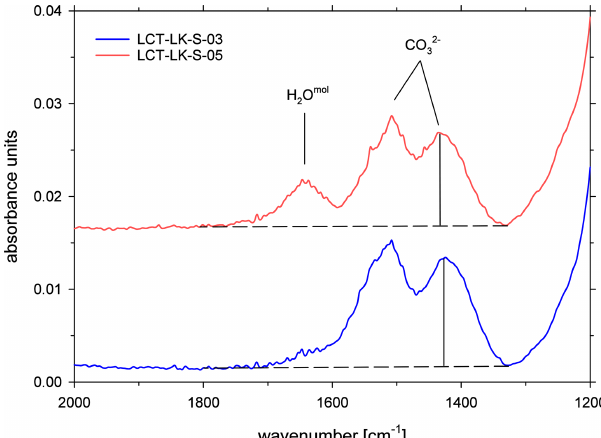
Figure 3. ATR-FTIR spectra of CO 2 -rich glasses (LCT-LK-S-03: anhydrous; LCT-LK-S-05: hydrous); the dashed lines mark the TT baselines that were applied to evaluate the peak heights of the car- bonate doublet; spectra are offset for clarity.